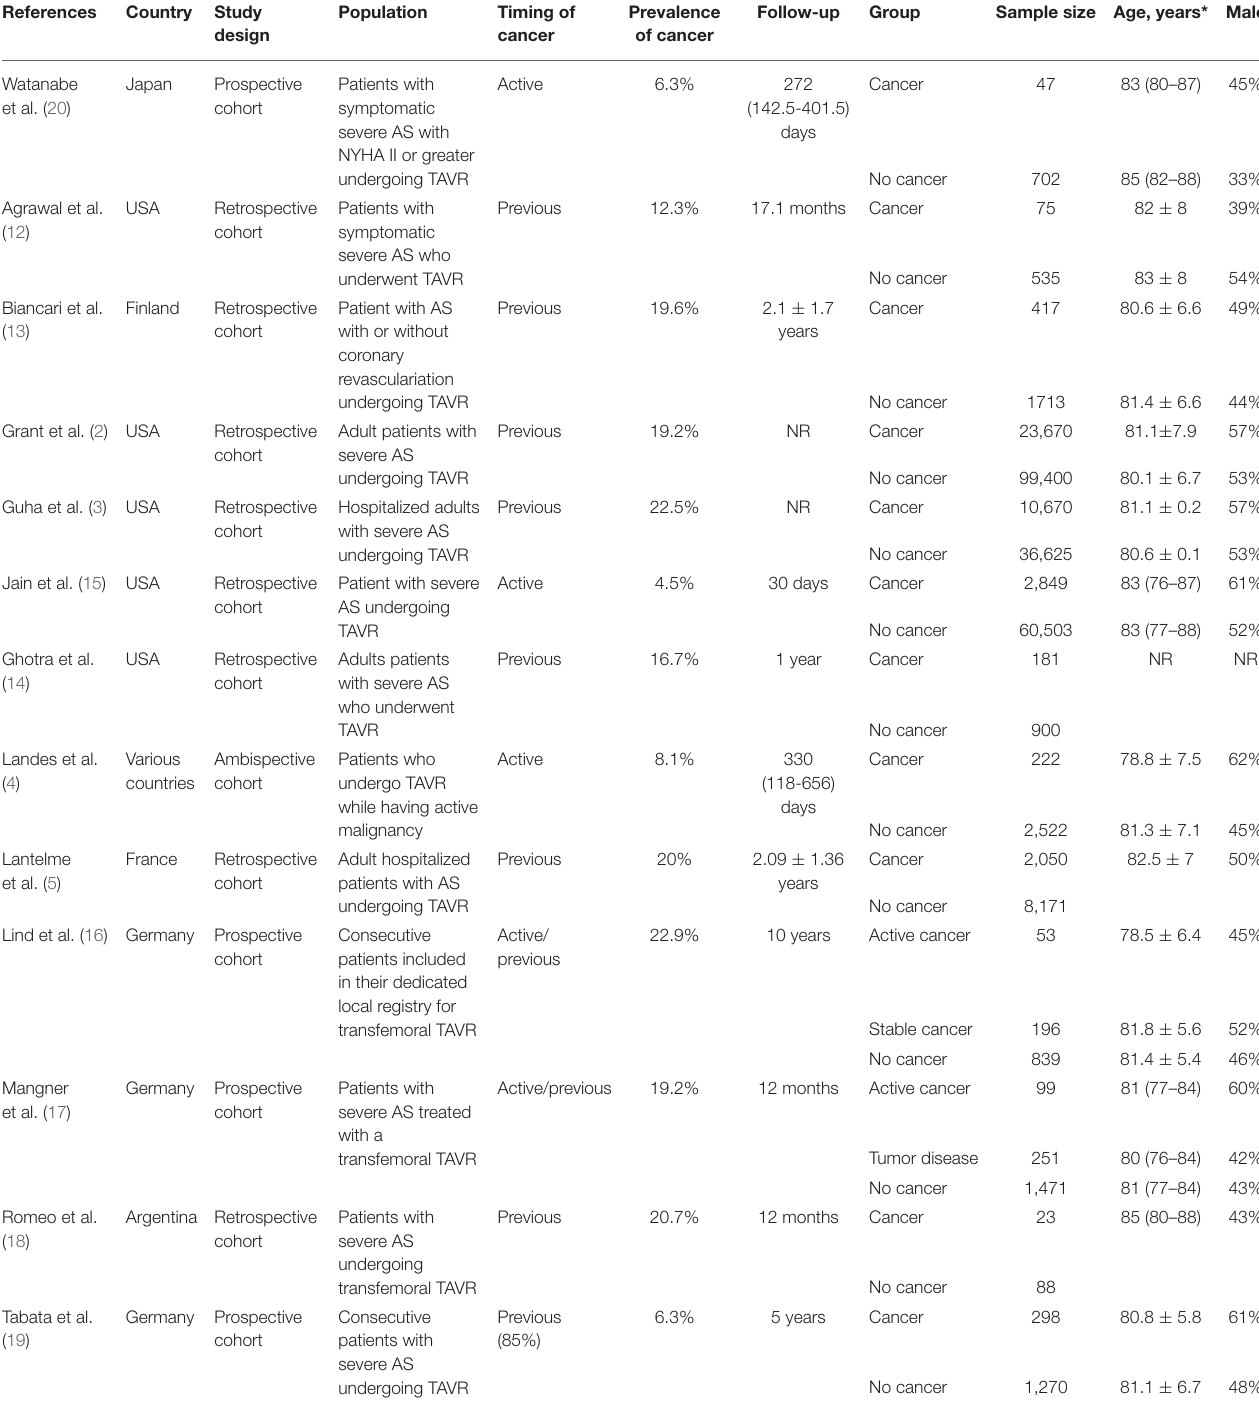
TABLE 1 | Characteristics of included